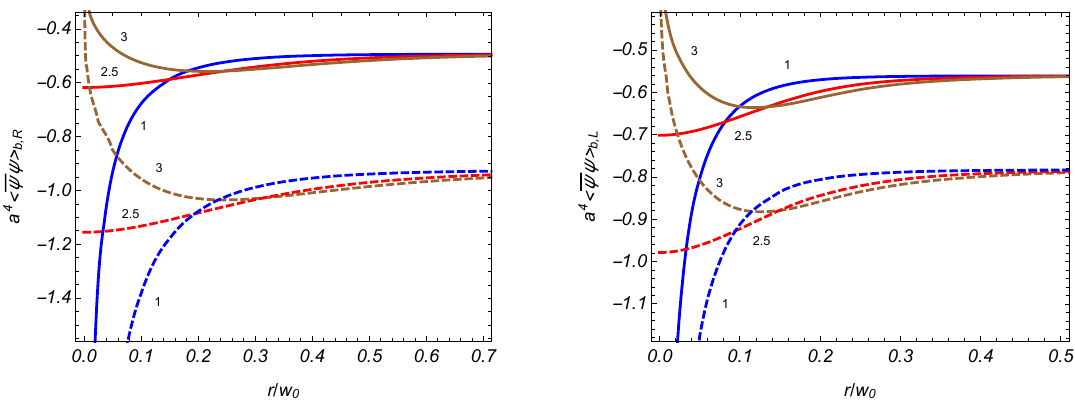
Figure 3 . Brane-induced FC as a function of the radial distance from the cosmic string for different values of the parameter q (numbers near the curves). The left and right panels correspond to the R- and L-regions with w/w 0 = 1 . 5 and w/w 0 = 0 . 75, respectively. The full and dashed curves present the FC for the fields s = +1 and s = 1. The graphs are plotted for ma = 1 and α 0 = 0 . −